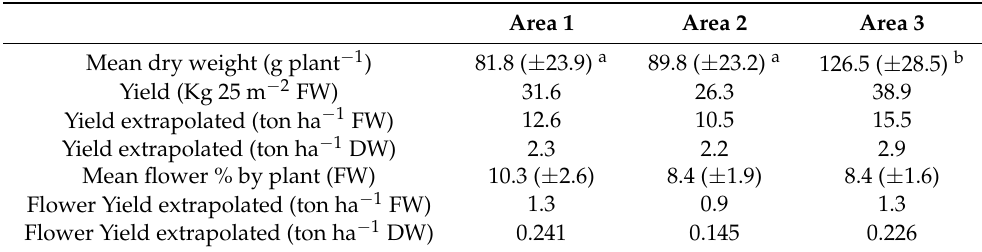
Table 2. Yield, percentage of flowers, and plant dry weight in the three areas. For the mean dry weight, significant differences between areas are indicated by different letters at the levels of α = 0.05. Standard deviation (SD) is expressed between parenthesis for the dry weight and flower percent ( n = 10). Area 1 Area